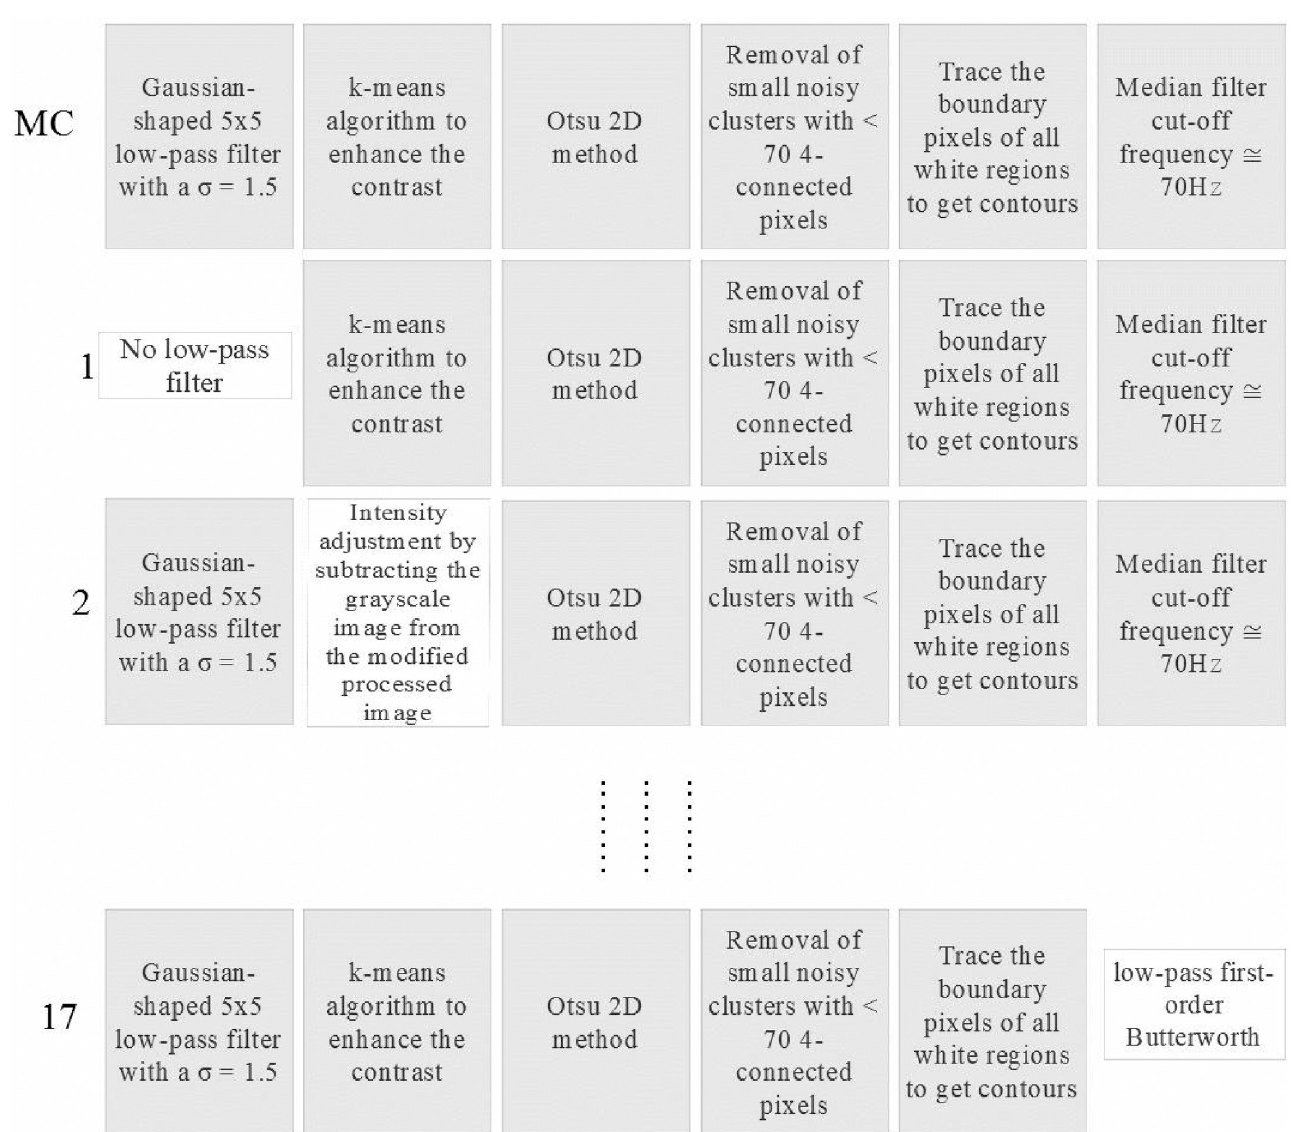
Fig 4. Workflow of the classification method. Example of the procedure used to evaluate the importance of each single processing technique. Specifically, the processing chains created by MC, 1 st , 2 nd , and 17 th are shown.